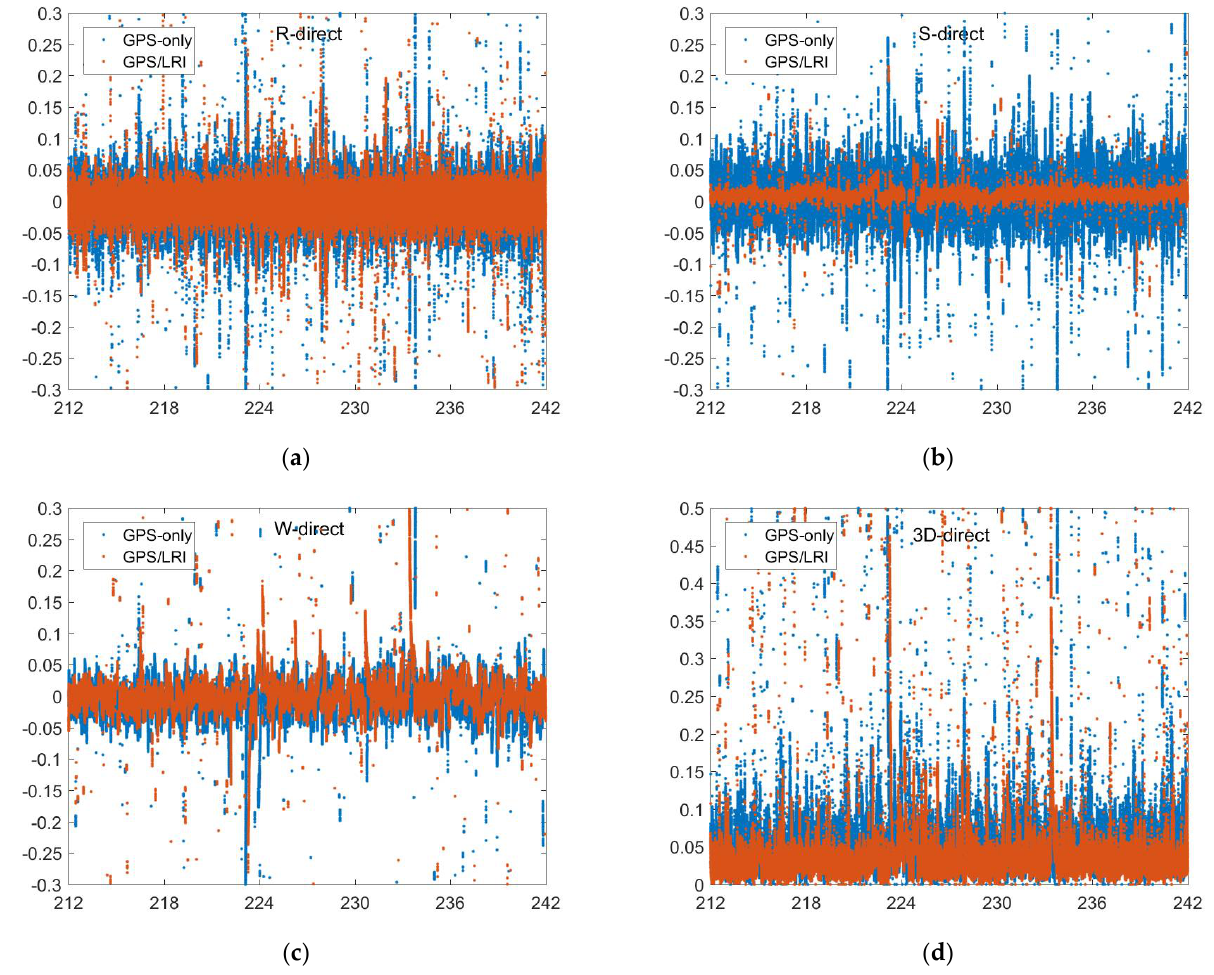
Figure 10. Reference orbit check for GRACE-FO-A in the R, S, W, 3D directions (days 212–242, ( a – d )).